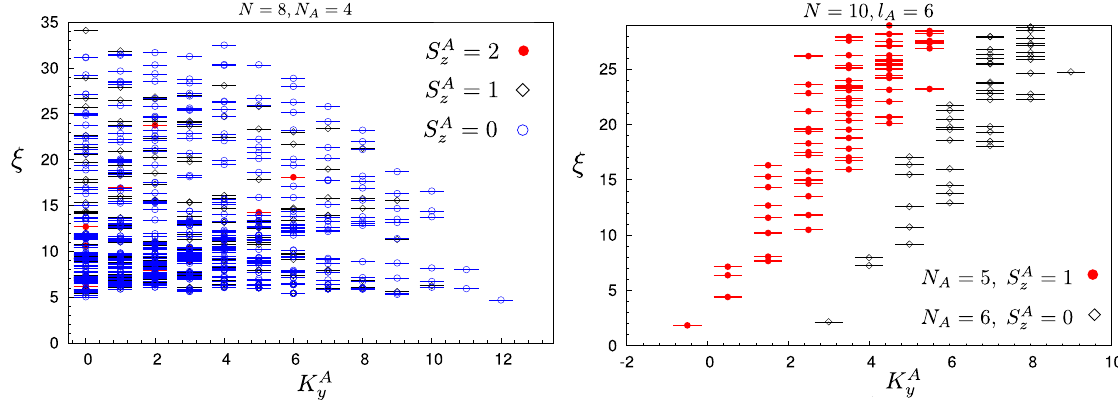
FIG. 10. PES (left panel) and OES (right panel) for the Ψ 221 state on a finite cylinder with aspect ratio equal to 1. For PES, we consider 4 particles. The PES is plotted as a function of momentum K A A . N ¼ 8 bosons, and the subsystem A contains N y of subsystem A ¼ Different values of S A z , the total z component of spin in part A , are indicated in the inset. For OES, we consider N ¼ 10 bosons, the subsystem A contains l A ¼ 6 orbitals, and the OES is plotted as a function of momentum K A y of subsystem A , for two values of the total number of particles in subsystem A ( N A ¼ 5 and N A ¼ 6